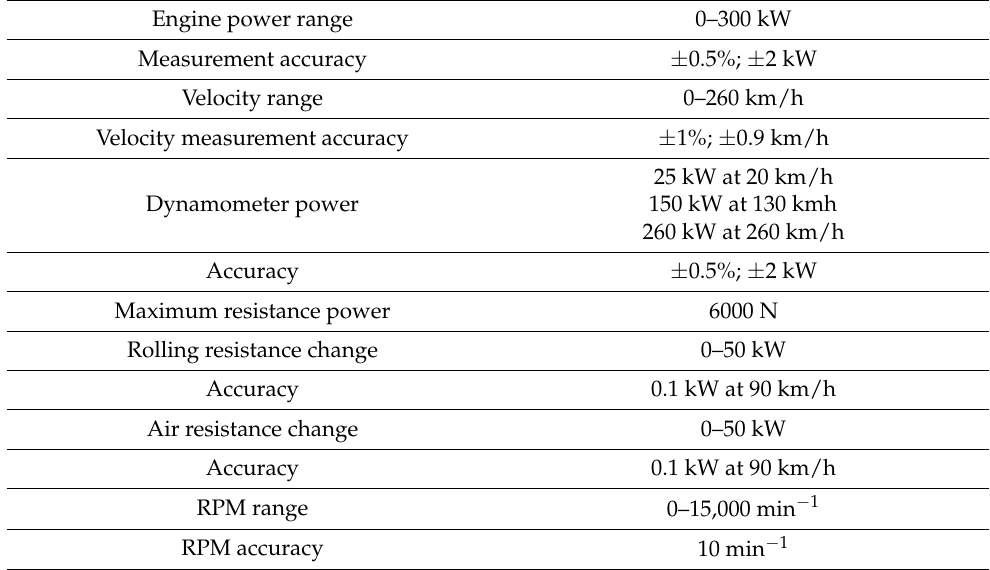
Figure 3. BOSCH FLA203 dynamometer stand [27]. Table 3. Dynamometer characteristics.